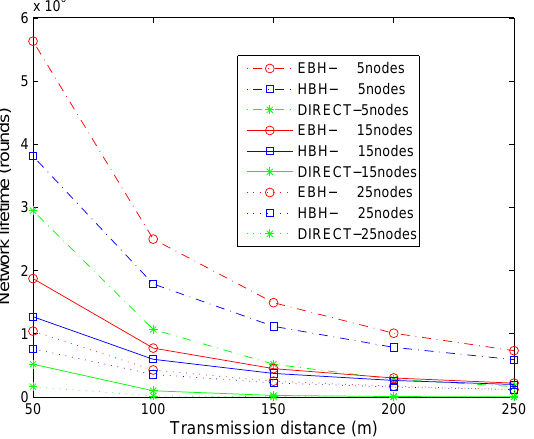
Figure 12. Network Lifetime with different internode